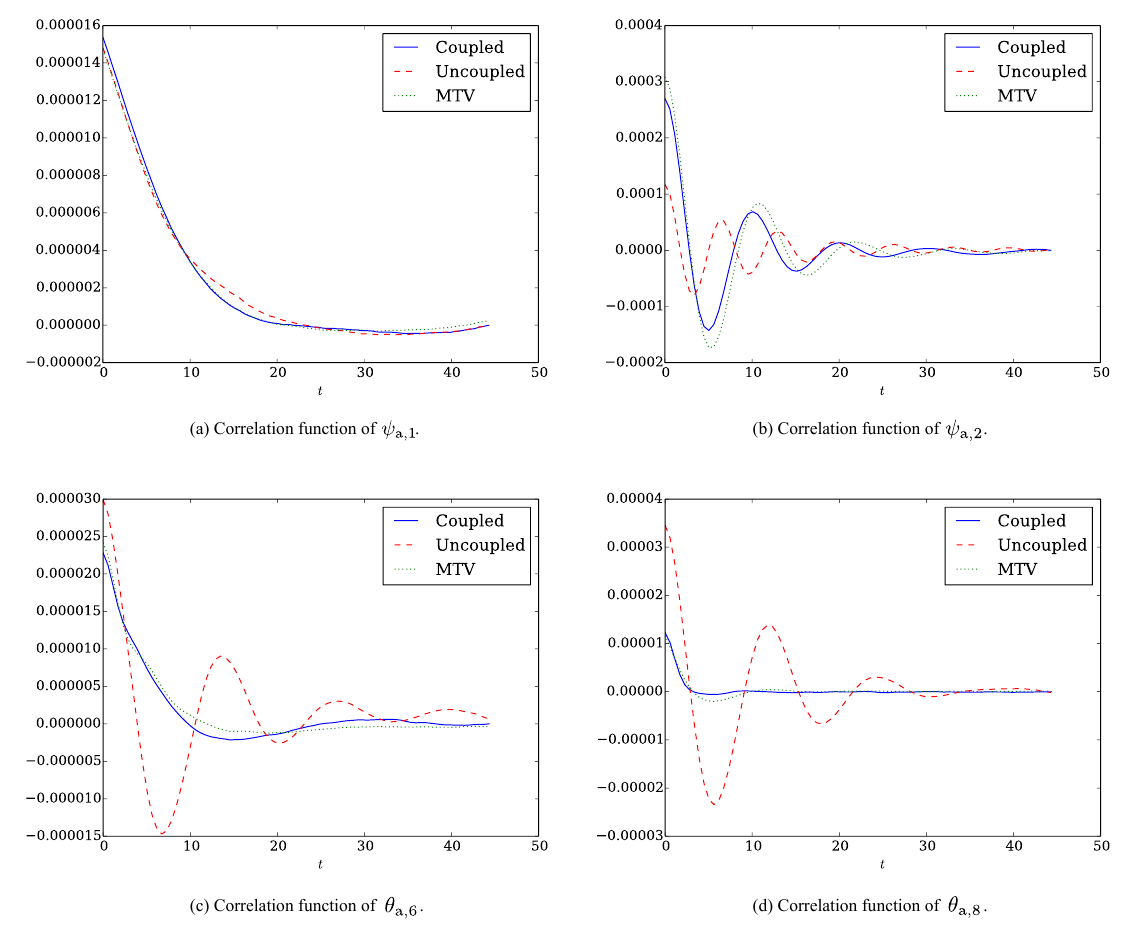
Figure 4. Correlation function of various variables for the wavenumber 2 parameterization and with the parameter set DDV2016. The correlation of the full coupled system (13), the uncoupled system and the MTV parameterizations are depicted as a function of the time lag t (in days). The WL parameterization results are not shown as it is unstable and